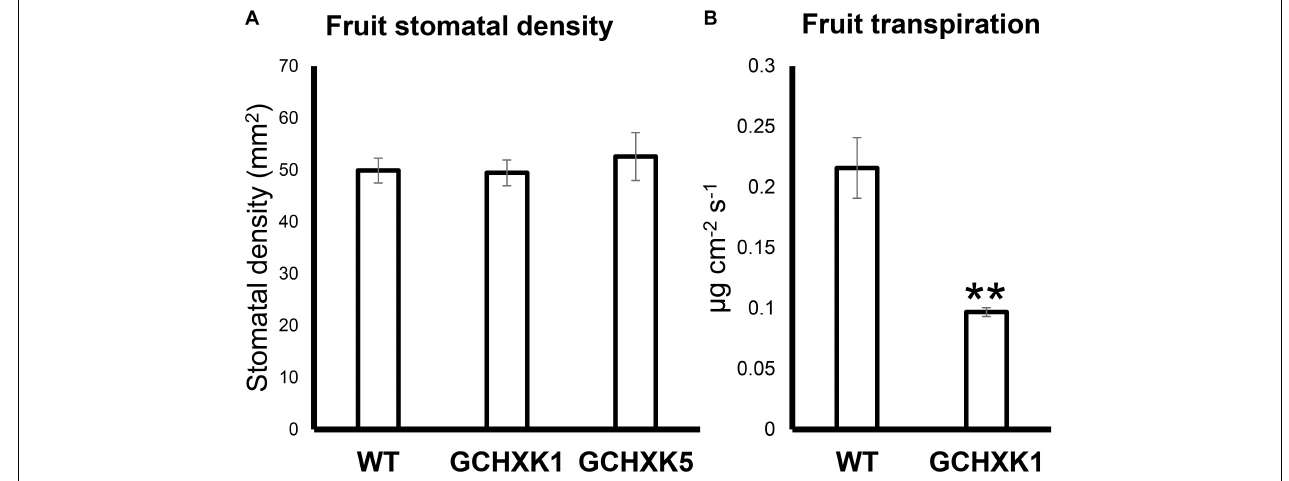
FIGURE 5 | Expression of AtHXK1 in guard cells of citrus fruits reduced fruit transpiration with no change in stomatal density. (A) Stomatal densities on WT, GCHXK1, and GCHXK5 fruits. For the WT, there were six biological repeats and for each GCHXK line, there were seven biological repeats. (B) Transpiration of green WT and GCHXK1 fruits, as measured with the LI-1600 steady-state porometer (WT: n = 8; GCHXK1: n = 12). Data displayed as means ± SE. Asterisks denote significant differences relative to the WT ( t -test, P < 0.01).